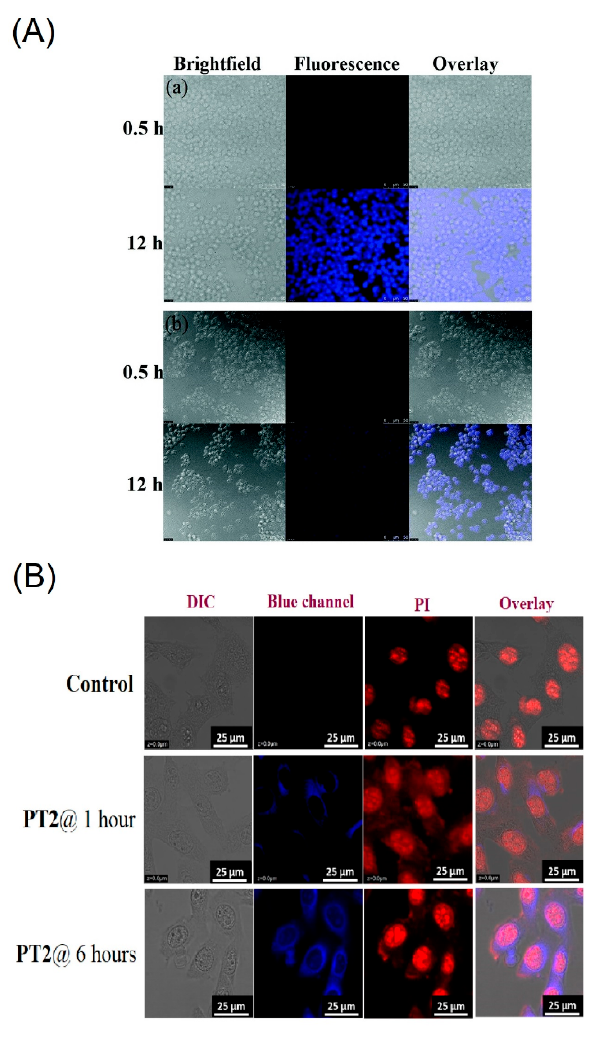
Figure 18. ( A ) Fluorescence images of Raw264.7 cells treated with ( a ) C30 and ( b ) C31 (assigned as “ PCS1 and PCS2 ” in the original report) at 0.5 and 12 h, respectively. Bright field image ( left ); flu- orescence image ( middle ); merged image ( right ). The scale bar is 50 mM (Reproduced with the au- thor’s permission of Ref. [99]). ( B ) Cellular images of C32 (represented as “ PT2 ” in the original